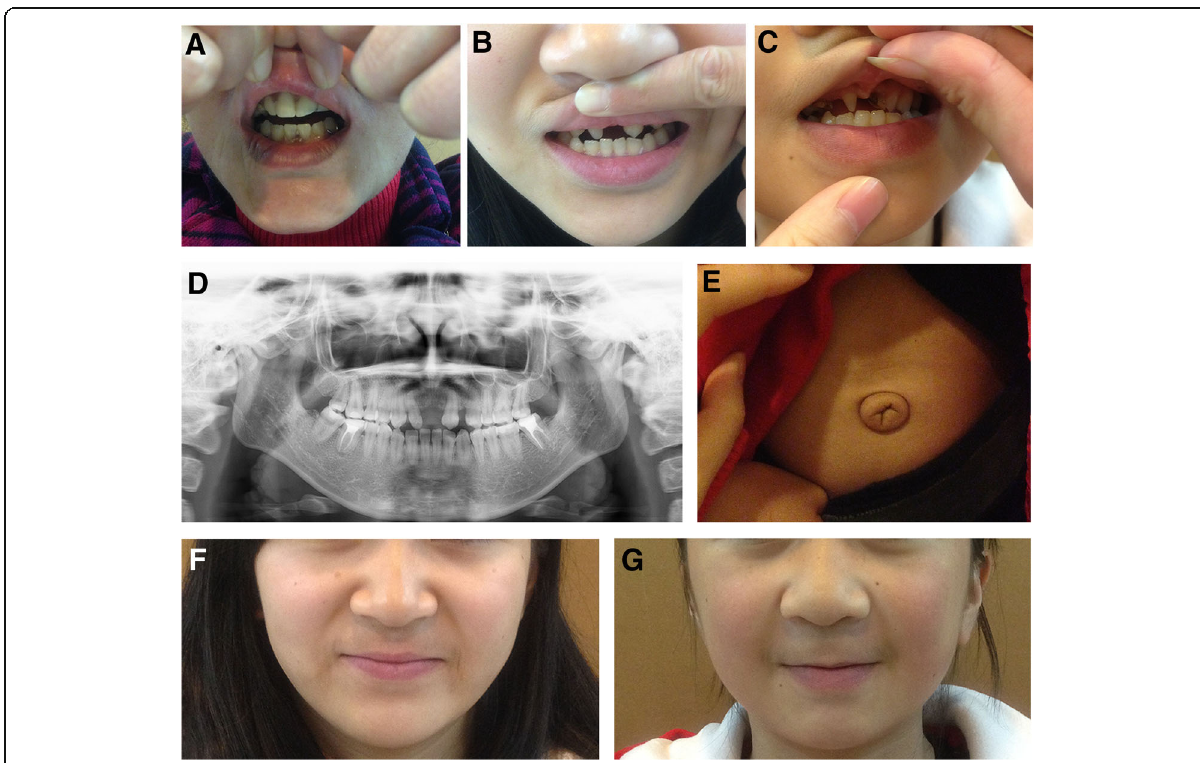
Fig. 3 Systemic clinic features of affected family members with Axenfeld-Rieger syndrome. No microdontia was observed for I-2 because of a dental implant ( a ). Apparent microdontia for II-1 and II-2 ( b and c ). Dental panoramic radiography for II-1 ( d ), and II-2 had similar dental panoramic radiography. Umbilical defect (redundant periumbilical skin) for II-2 ( e ). All three patients exhibited the same sign when they underwent general physical examination. Broad nasal bridge of II-1 and II-2 ( f and g